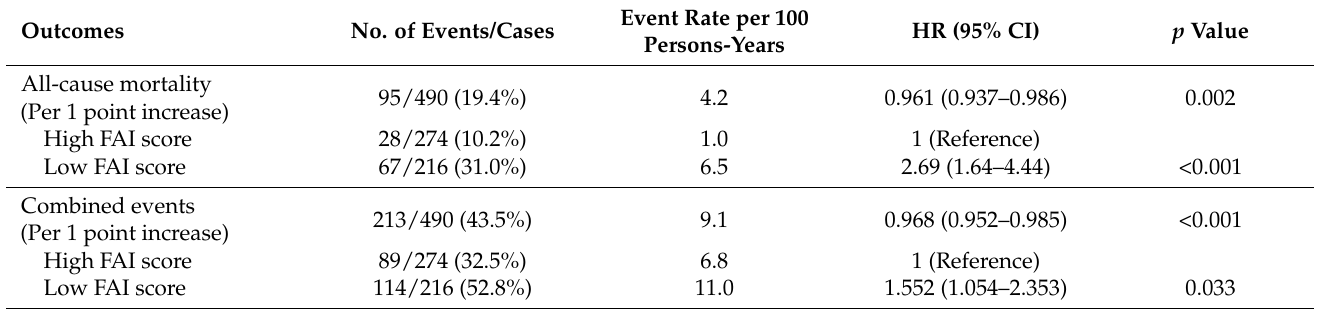
Figure 4. Kaplan–Meier curve for combined events according to the FAI in the overall cohort, females, and males. The rate of combined events was significantly higher in the low FAI score group than those in the high FAI score group in the overall cohort ( A ), females ( B ), and males ( C ). FAI, Frenchay Activities Index. Table 2. Cox proportional hazard models of the FAI for all-cause mortality and combined